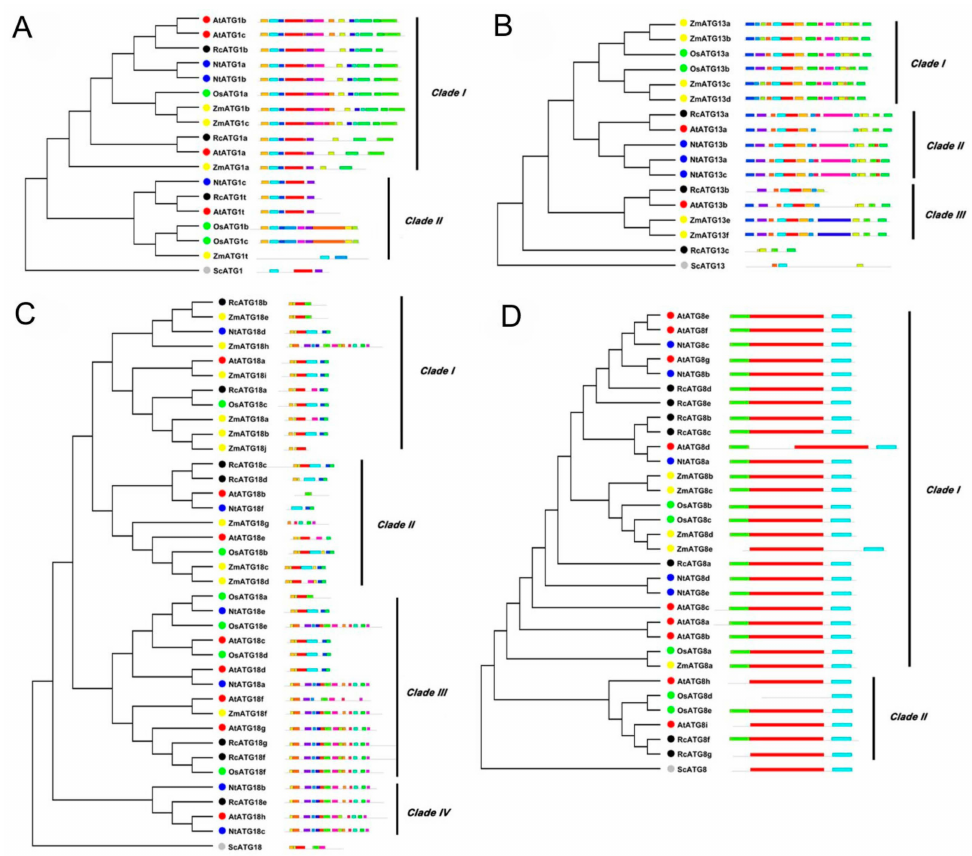
Figure 2. Bioinformatics analysis of autophagy subfamily genes in di ff erent species (i.e., Rc, Ricinus communis L. ; At, Arabidopsis thaliana ; Os, Oryza sativa ; Nt, Nicotiana tabacum ; Zm, Zea mays ; Sc, Saccharomyces cerevisiae ). ( A ) Phylogenetic tree and motif analysis of the ATG1 subfamily. ( B ) Phylogenetic tree and motif analysis of the ATG13 subfamily. ( C ) Phylogenetic tree and motif analysis of the ATG18 subfamily. ( D ) Phylogenetic tree and motif analysis of the ATG8